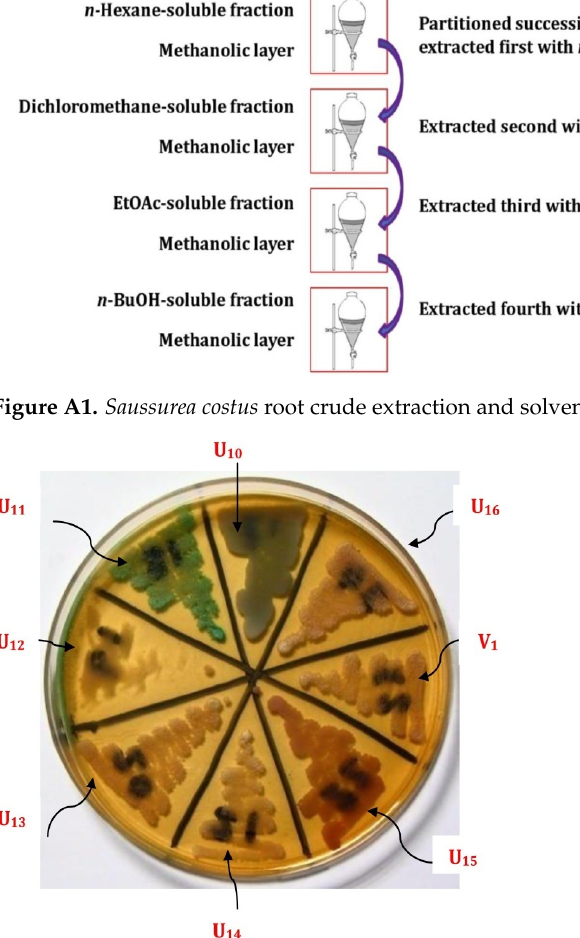
Figure A2. Model for the growth of some isolates after 48 h on CHROM agar. (U 10 ) blue to gray colonies ( C. tropicalis ); (U 11 ) green colonies ( C. albicans ); (U 12,13,14,16 and V 1 ) off-white colonies ( C. parapsilosis ); (U 15 ) pink colonies ( C. glabrata ).